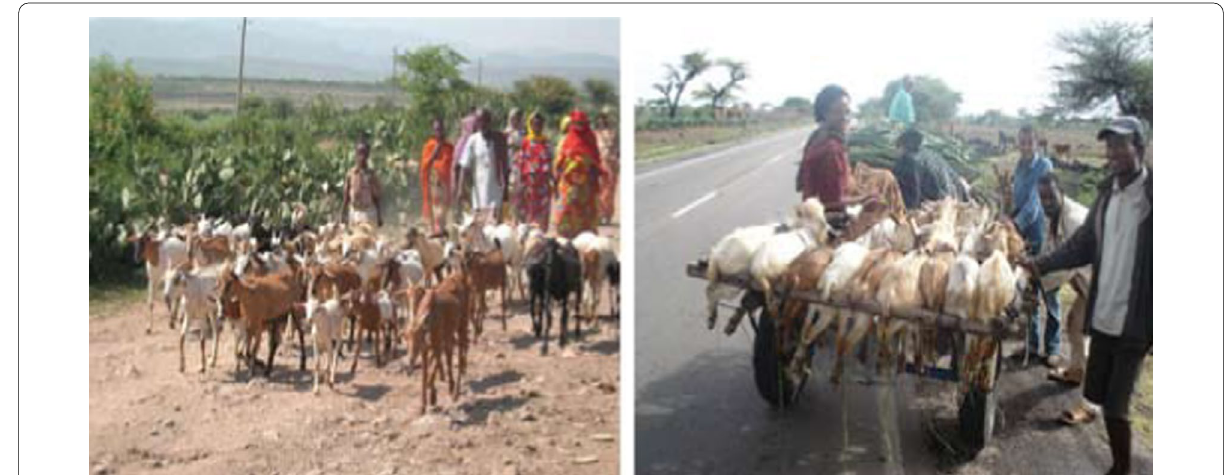
Fig.2 Trekking and transporting goats to market in some parts of the country (Solomon et al.